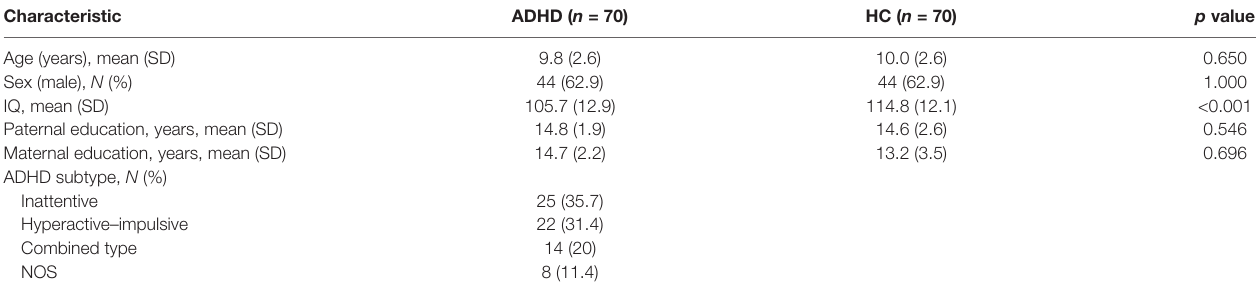
TABLE 1 | Demographic and clinical characteristics of the age- and gender-matched attention-deficit hyperactivity disorder (ADHD) and healthy control (HC) groups. Characteristic